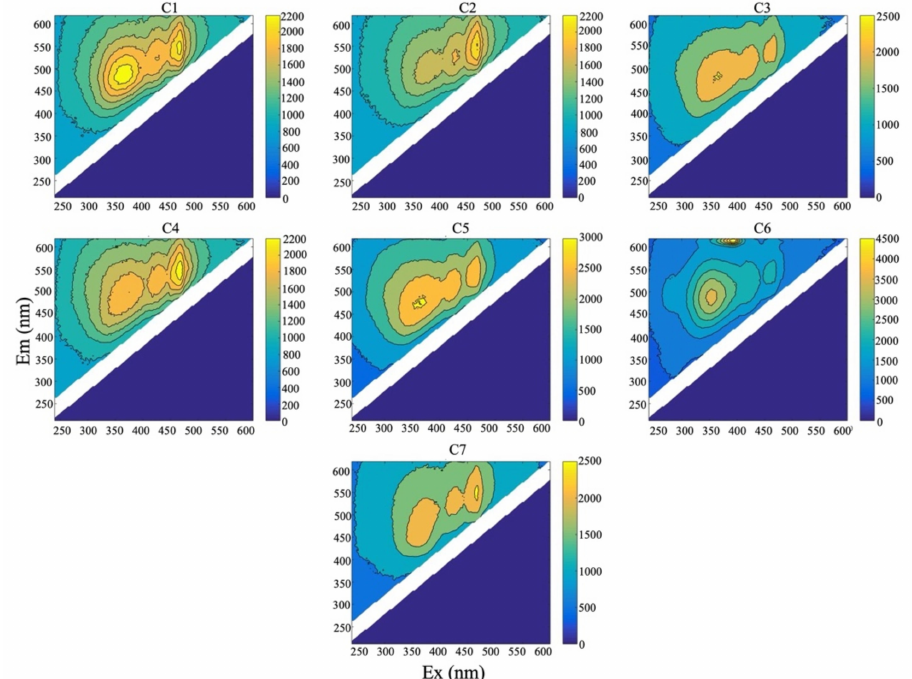
Figure 4. Composition of humic acids (HAs) of different treatments. Compost labels according to the target waste: ( C1 ) fish waste; ( C2 ) horse manure; ( C3 ) sewage sludge; ( C4 ) green waste; ( C5 ) kitchen biowaste; ( C6 ) H. illucens frass; and ( C7 ) vermicompost. The color scale is presented in relative